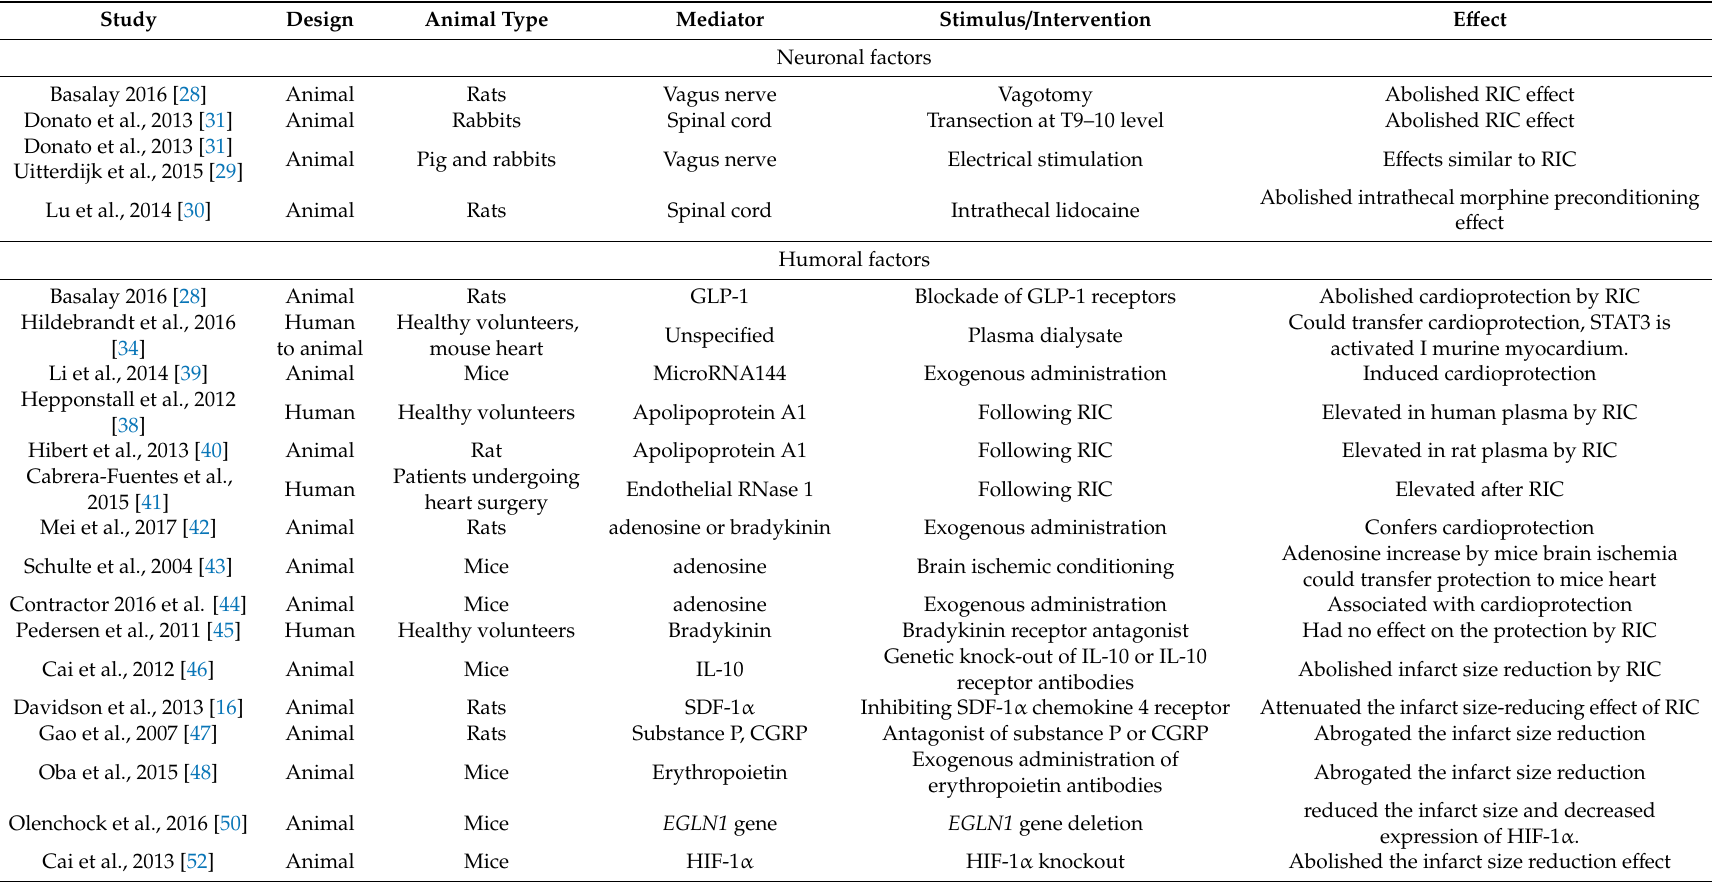
Table 1. Studies on the humoral and neuronal mediators of remote ischemic